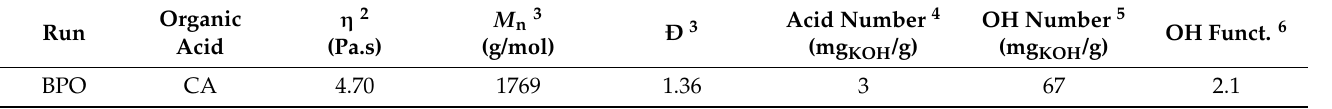
Table 2. Properties of bio-polyol 1 .